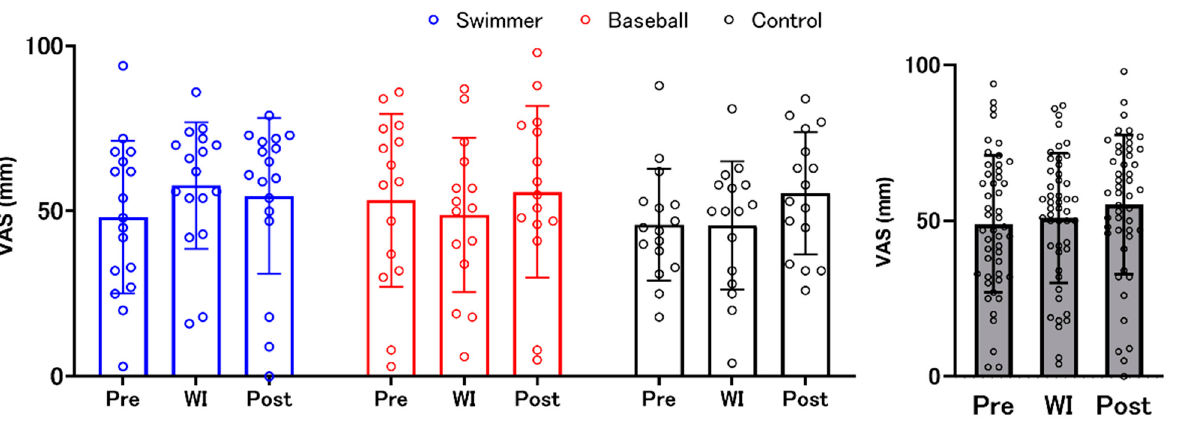
groups. Gray bars represent all participants with individual data (open circles). IAcc scores at post-water immersion (WI) were higher than those at pre-WI and during WI.